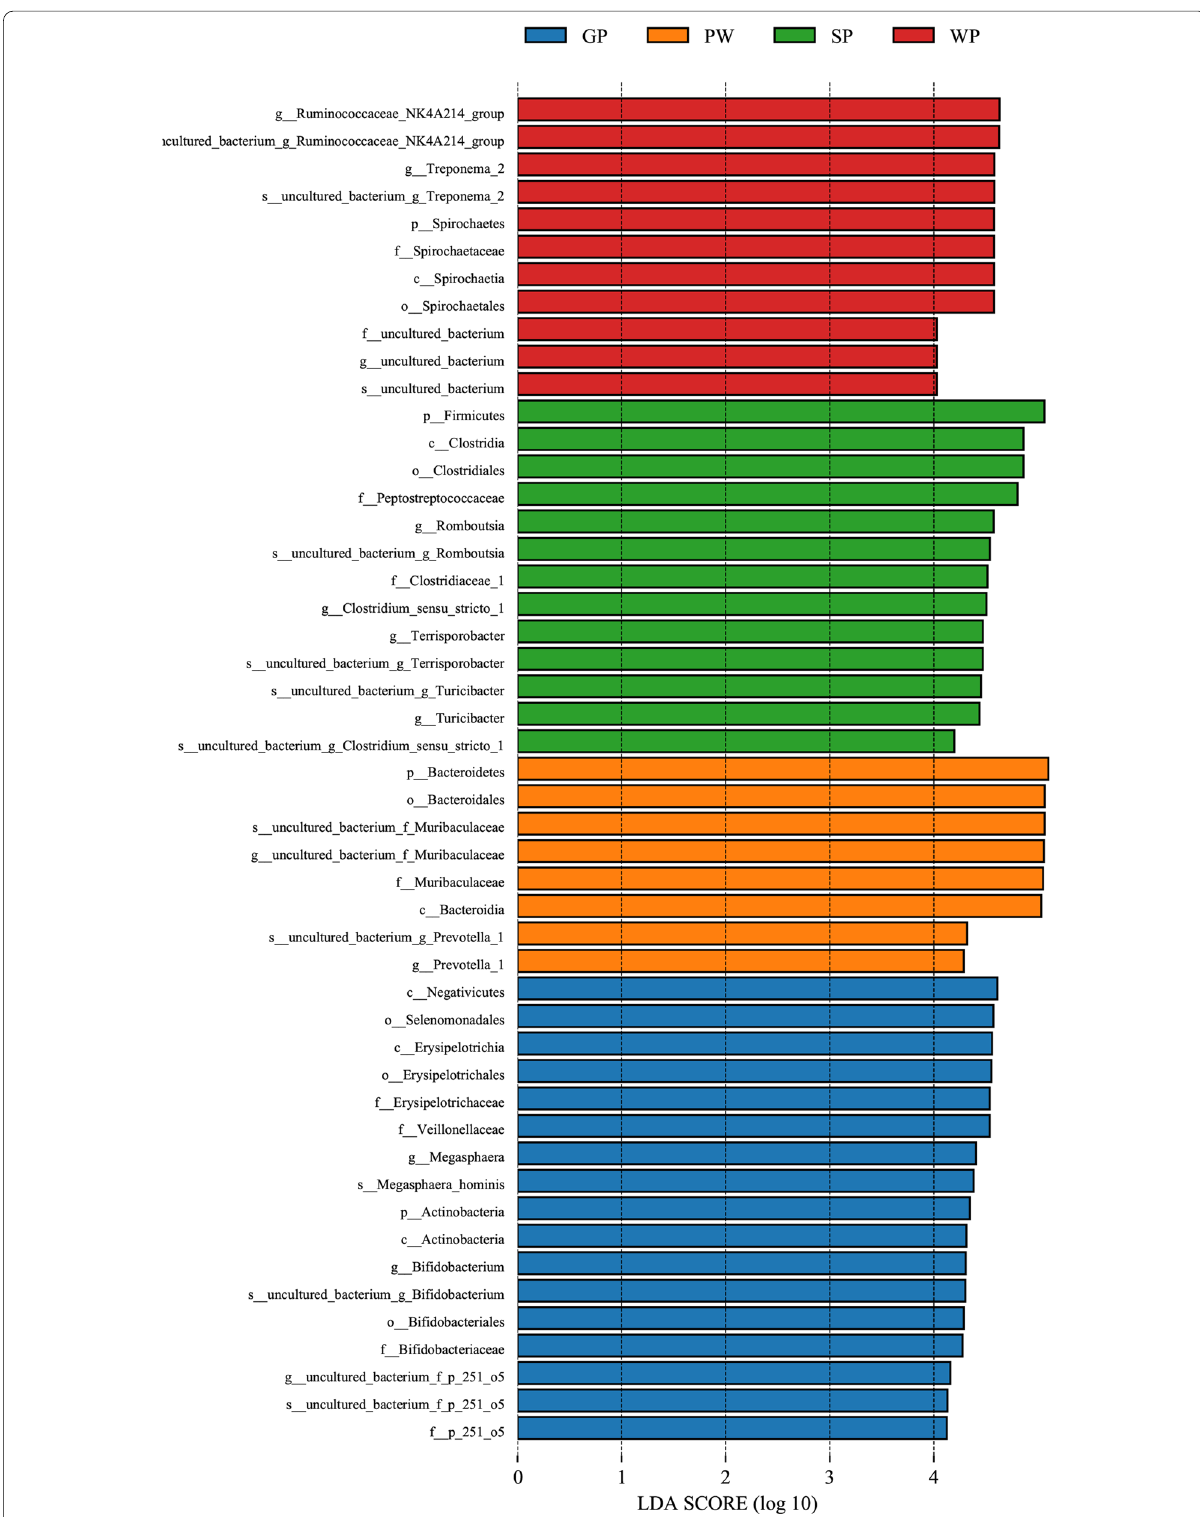
Fig. 2 Fecal microbiota phylotypes differ of pigs at various grow stages. A Histogram of linear discriminant analysis (LDA) scores computed for differences in the proportions of fecal microbiota. Taxa meeting an LDA significant threshold of > 4 are